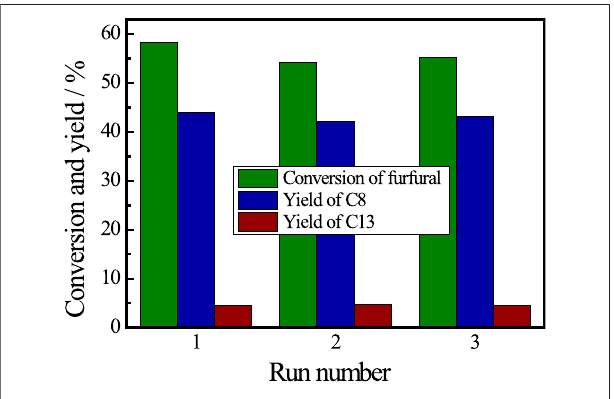
FIGURE 5 | Recyclability test of De-chitin for aldol condensation. Reaction conditions: furfural 0.48 g, acetone 1.16 g, De-chitin 0.1 g, 140 ° C, 4